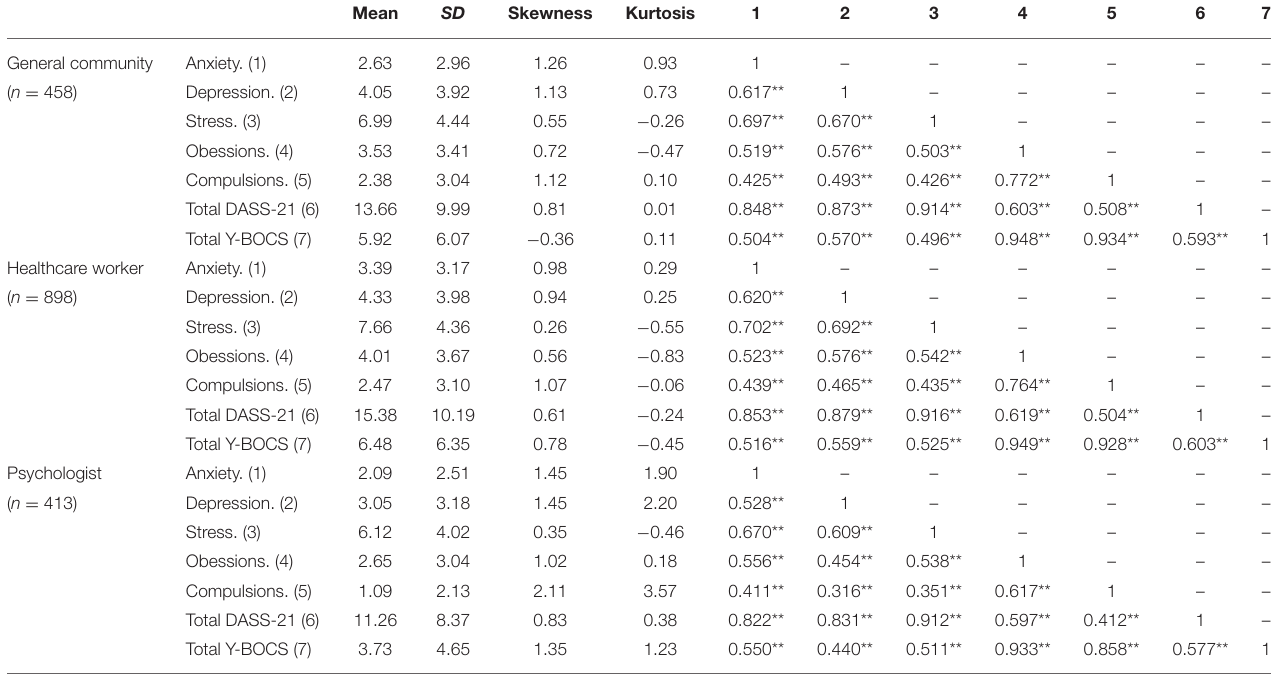
TABLE 2 | Descriptive statistics on the variables under study and zero-order correlations among each other. Mean SD